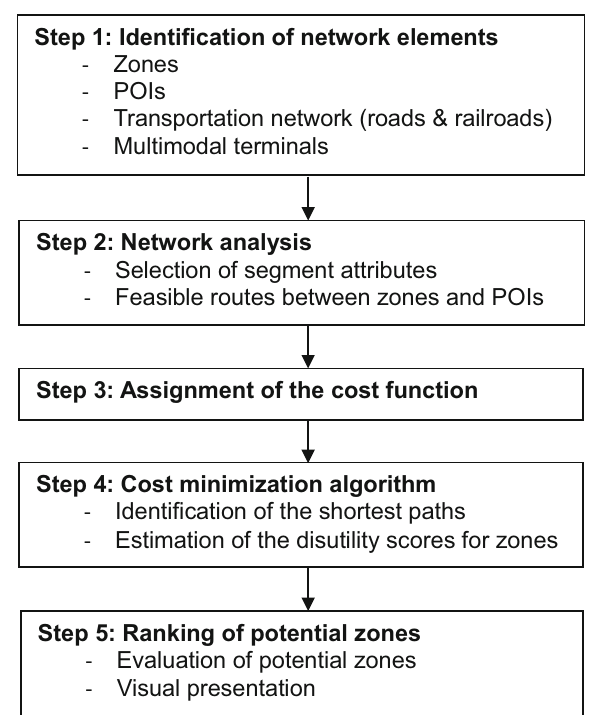
Fig. 1 Analysis steps for evaluating potential zones for a HAZMAT